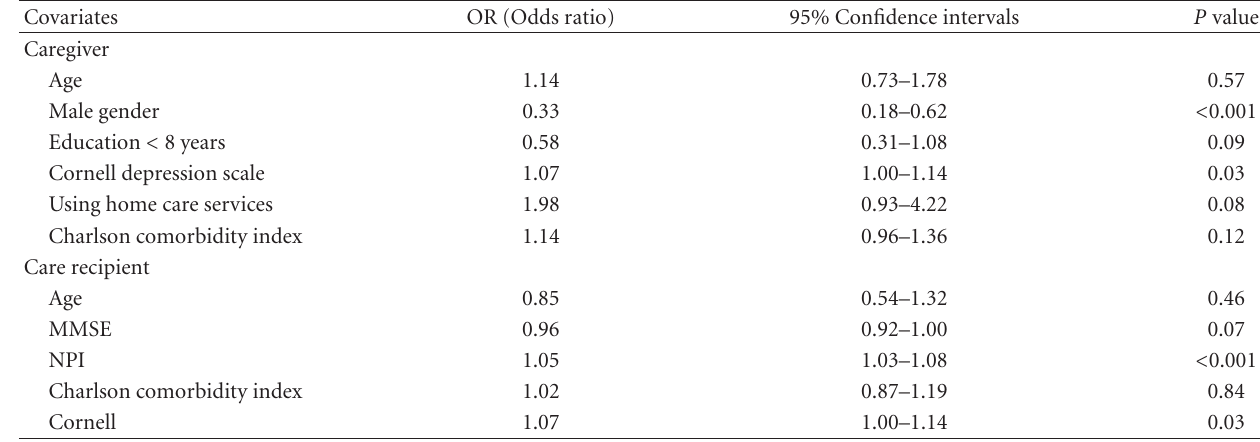
Table 2: Logistic regression analysis exploring independent determinants associated with high burden (Zarit > 40 points) in dementia spousal